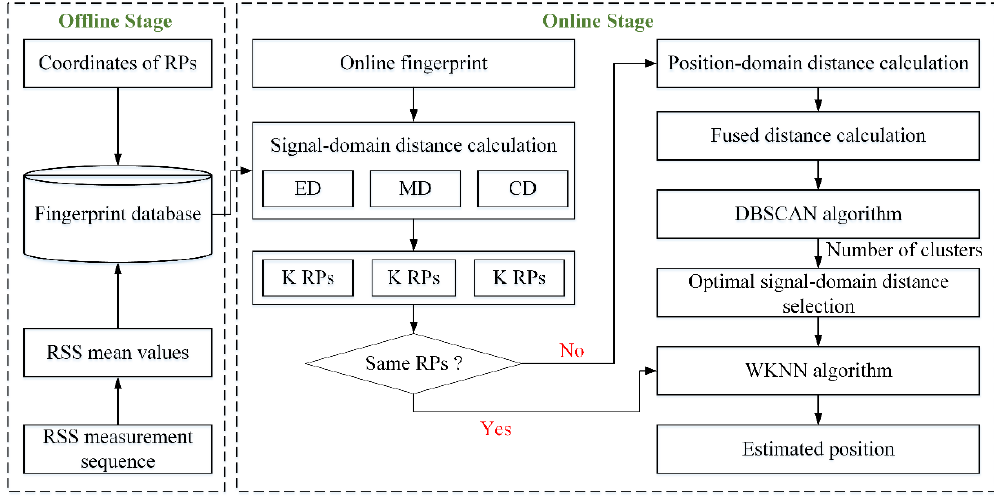
Figure 3. The system overview of the proposed method.